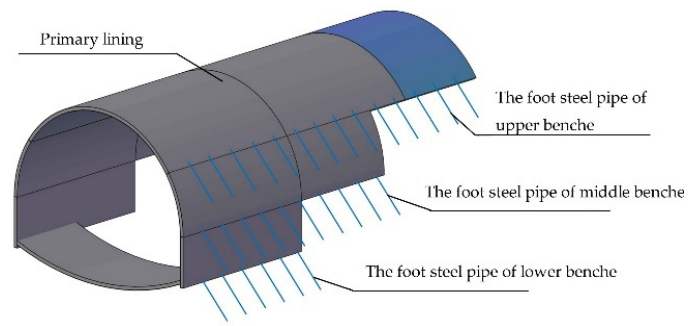
Figure 6. Position of FSP under the three-benches and seven-steps excavation method.